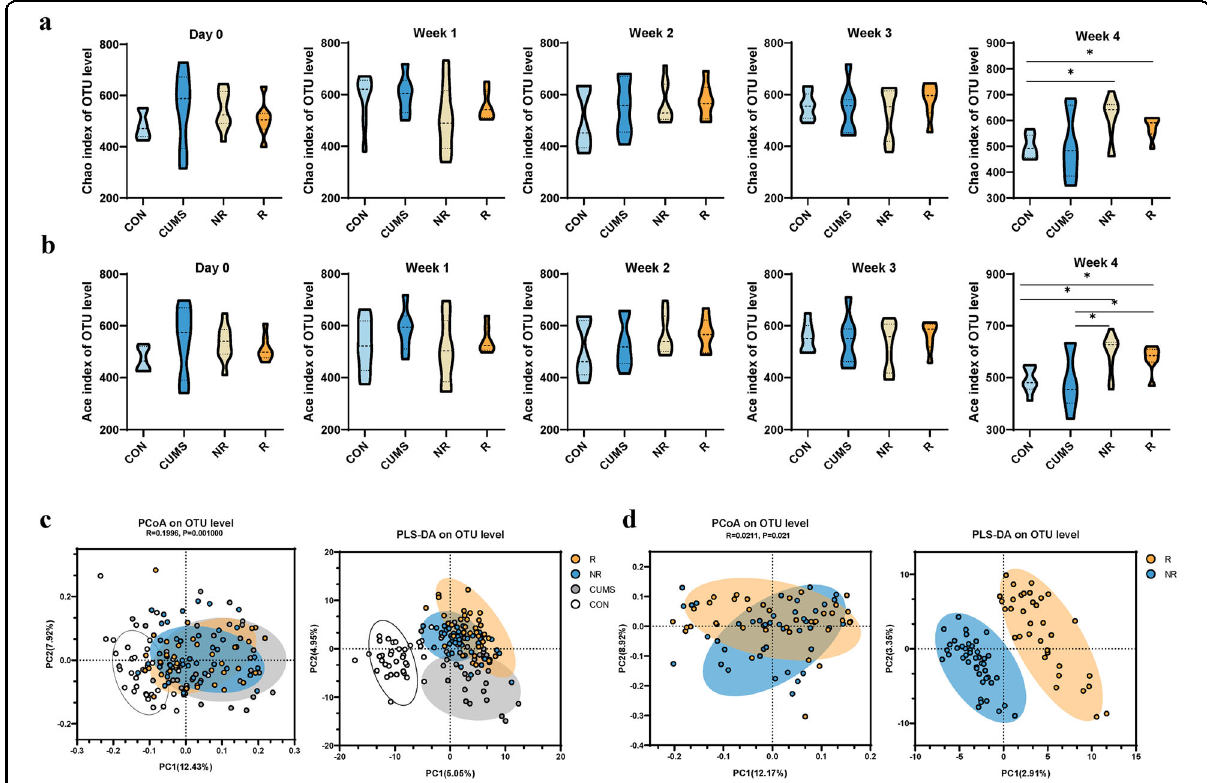
Fig. 2 Longitudinal changes in microbial diversity in different groups. Bacterial richness, here presented by Chao indices ( a ) and Ace indices ( b ) obtained at different time points from day 0 to week 4, NR and R group was higher than those in CON and CUMS groups in week 4. Data are presented with means and standard errors (* p < 0.05, Wilcoxon rank-sum test). Principal coordinate analysis (PCoA) plots based on unweighted UniFrac distances and the partial least squares-discriminant analysis (PLS-DA) showed distinct clusters on the OTU level among the four groups ( c ), and between the R and NR group ( d ), the bacterial communities of the R and NR group clustered separately. Statistical signi fi cance was determined by an ANOSIM with 999 permutations. The percentage of variation explained by principal co-ordinates is marked on the